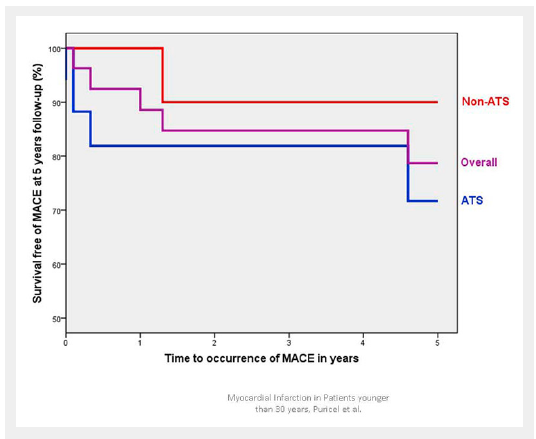
Cumulative survival free of major cardiac adverse events (MACE) in patients <30 years presenting with acute coronary syndrome. ATS = atherosclerosis; non-ATS = patients without angiographic evidence of